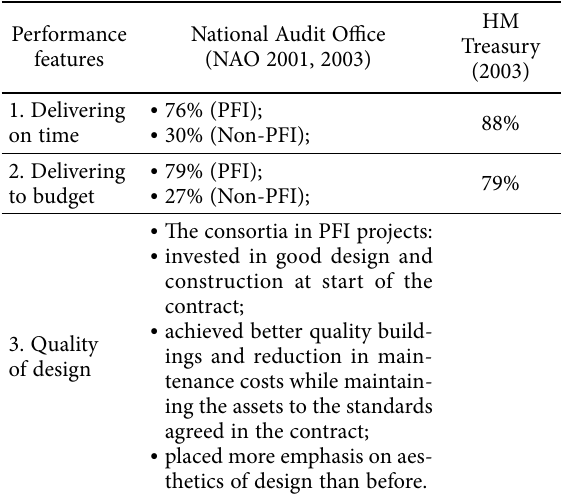
Table 2. PFI Construction Performances in the UK